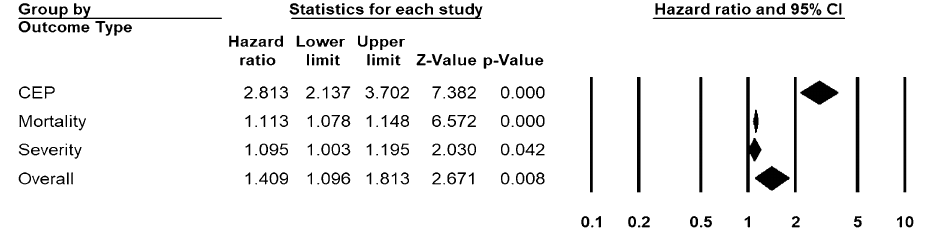
Figure 4. Pooled estimate of unadjusted hazard ratios for the association of D-dimer with disease progression in patients with COVID-19.